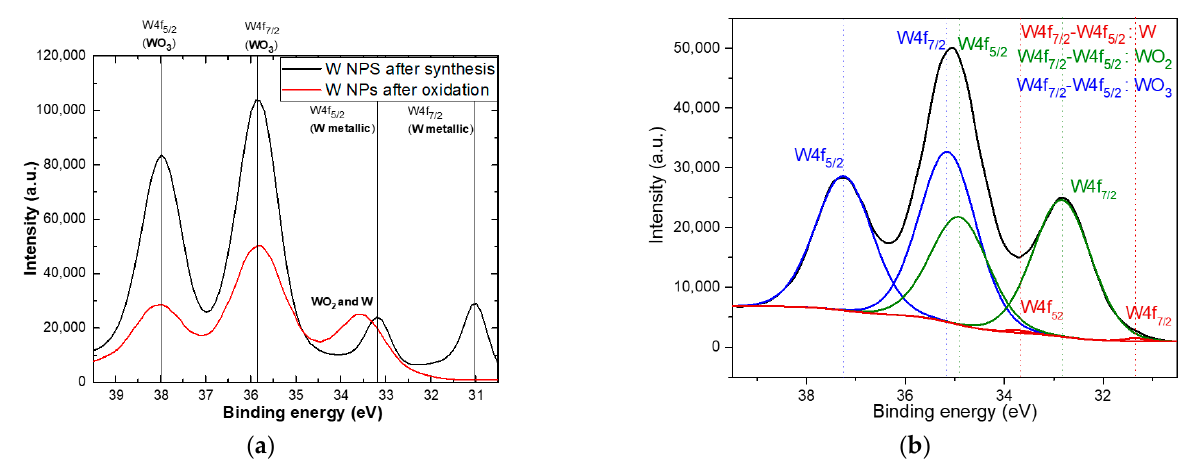
Figure 5. ( a ) Comparative XPS spectra of initial tungsten nanoparticles, respectively tungsten oxide particles, obtained after oxidation process. ( b ) XPS deconvolution results of the W4f region for W nanoparticles obtained after oxidation.